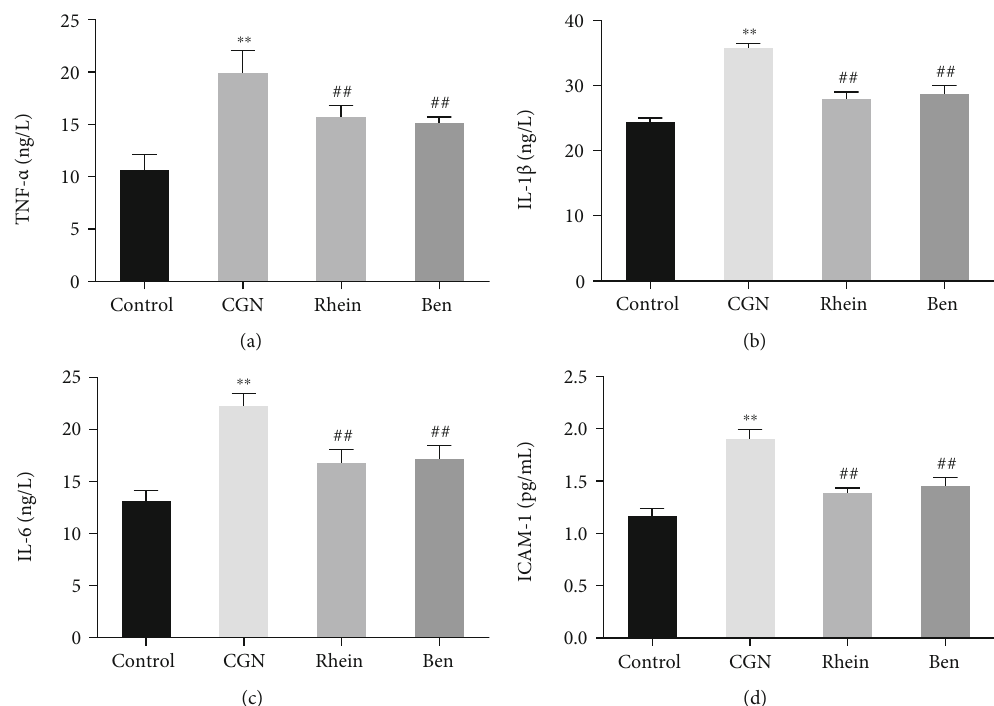
Figure 2: E ff ect of rhein on renal in fl ammatory factors in rats with chronic glomerulonephritis. (a – d) ELISA was used to detect the expression of TNF- α (a), IL-1 β (b), IL-6 (c), and ICAM-1 (d) in renal in fl ammation of rats in each group ( n = 6 ). ∗∗ p < 0 : 01 , control group; ## p < 0 : 01 , CGN